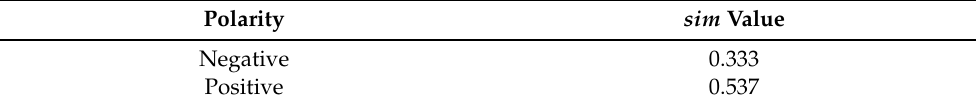
Table 2. sim results grouped by SA